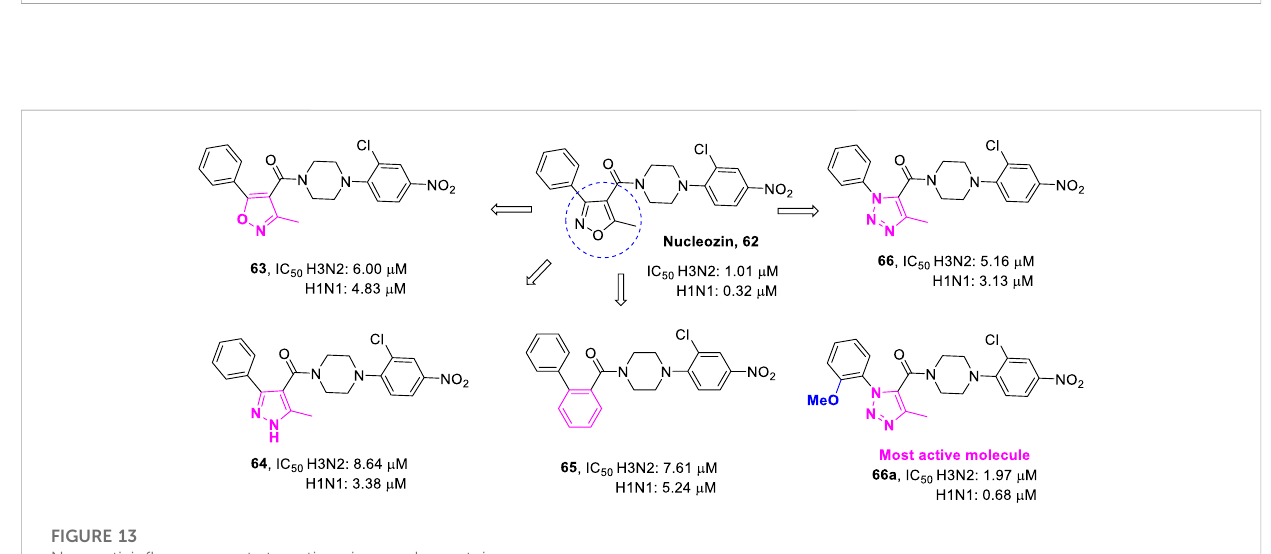
FIGURE 13 New anti-in fl uenza agents targeting virus